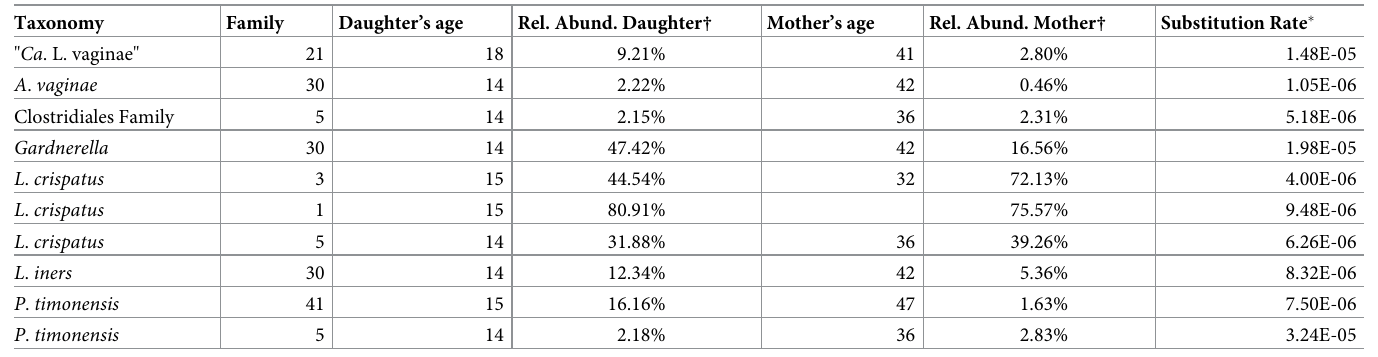
Table 1. MAGs identified in mother-daughter